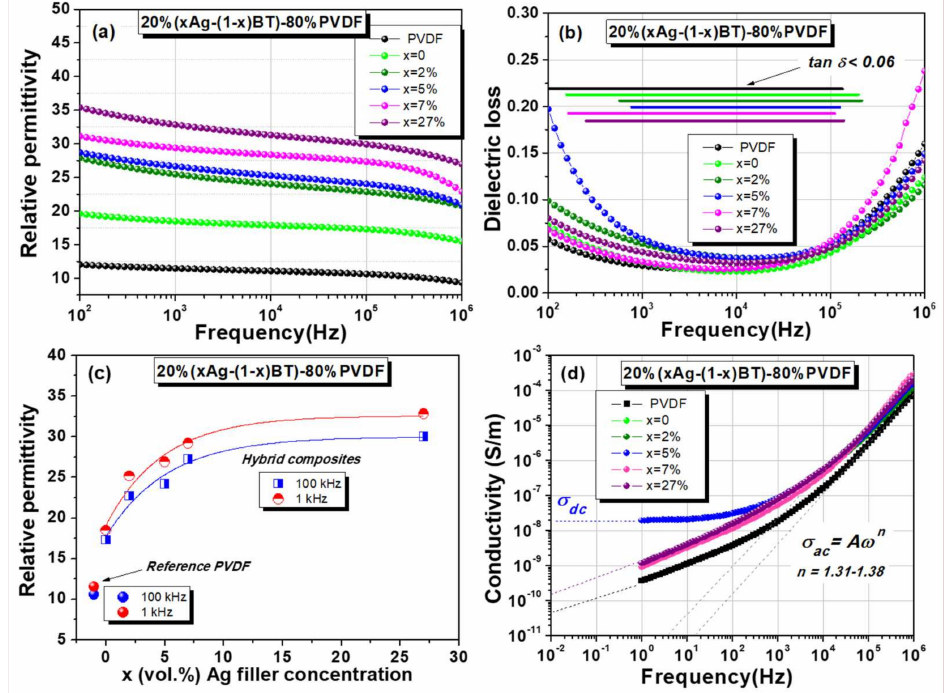
Figure 6. Room temperature dielectric properties of 20%( x Ag − (1 − x )BT) − 80%PVDF flexible com- posites as a function of frequency: ( a ) Relative permittivity; ( b ) Dielectric loss ( tan δ ) (the frequency range for which tan δ ≤ 0.06 is shown, for each composition); ( c ) Relative permittivity vs. Ag filler concentration (the lines are guides for the eye) ( x ); ( d ) Conductivity vs. frequency in log-log